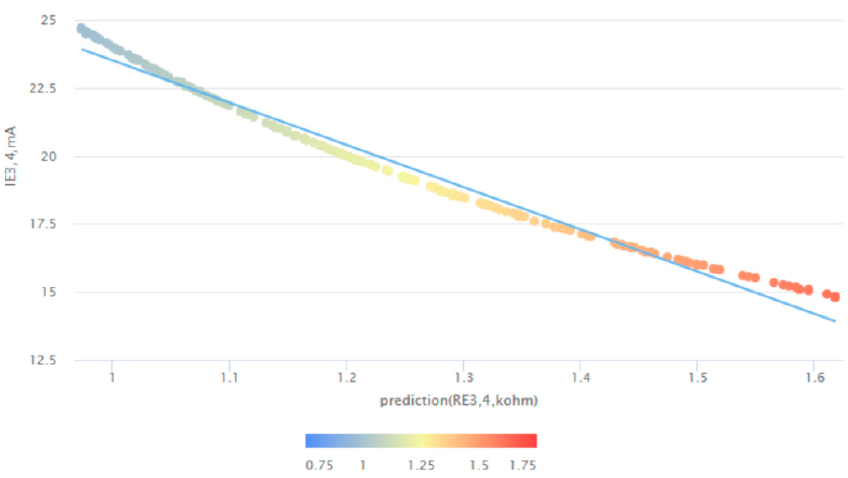
Figure 11. Predicted dependence between R E 3.4 and I E 3,4